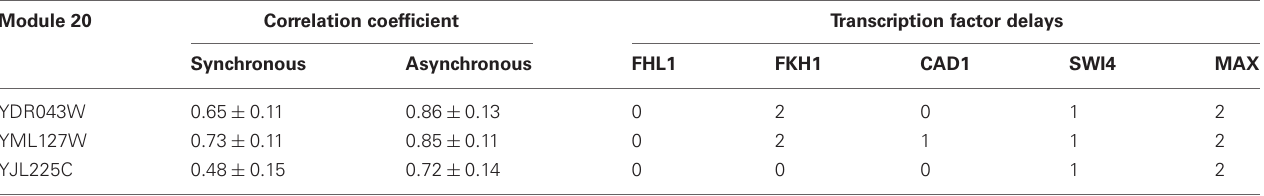
Table 3 | Maximum correlation coefficients for three cascades modeled by synchronous or asynchronous ANNs. Module